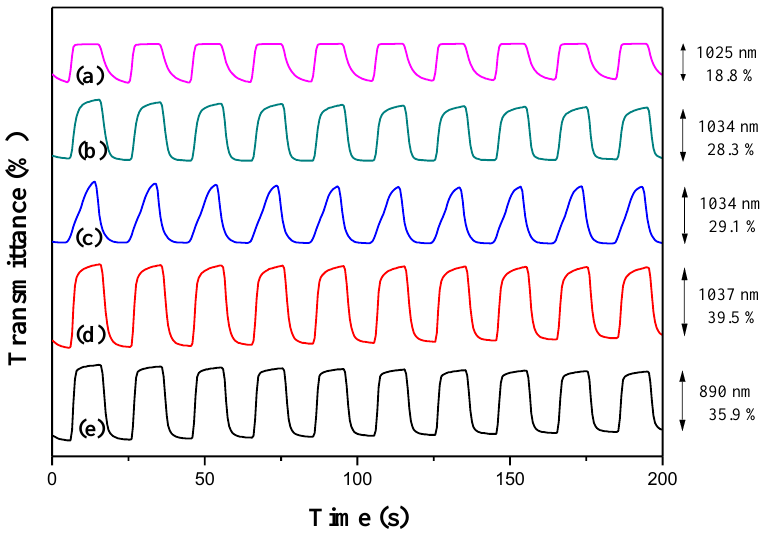
Figure 6. Transmittance changes of ( a ) PDiCP; ( b ) P(DiCP- co -CPDT); ( c ) P(DiCP- co -CPDT2); ( d ) P(DiCP- co -CPDTK); and ( e ) P(DiCP- co -CPDTK2) electrodes in a 0.2 M LiClO 4 containing ACN/DCM (1:1, by volume) solution.